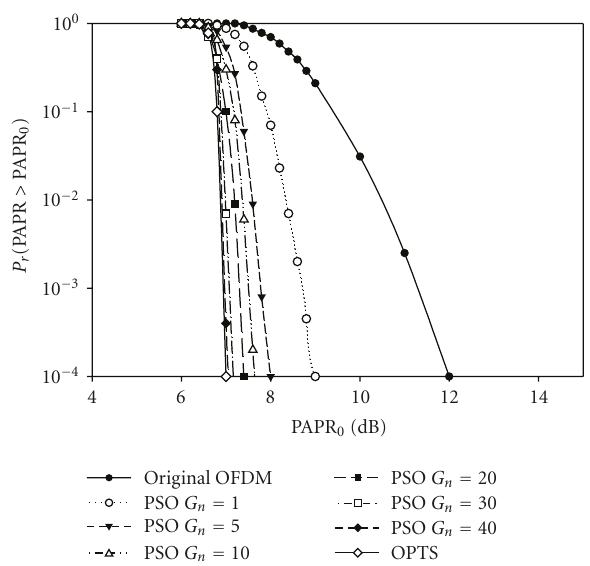
Figure 3: CCDF of PSO technique for di ff erent G n when M = 16 and W =